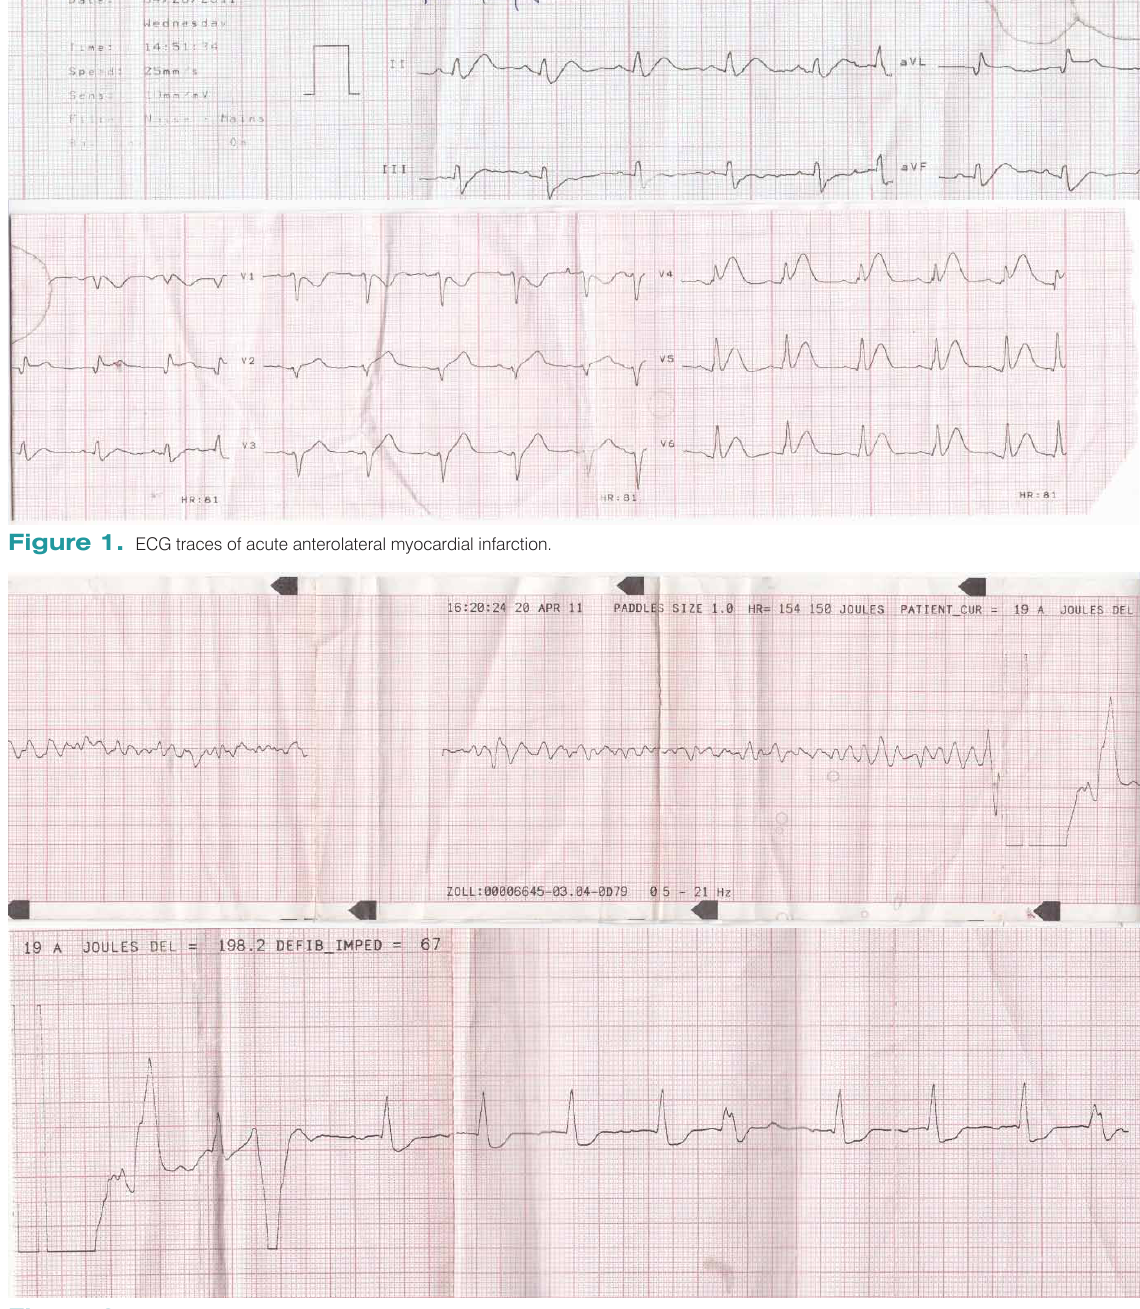
Figure 2. ECG tracing of ventricular fibrillation with a DC